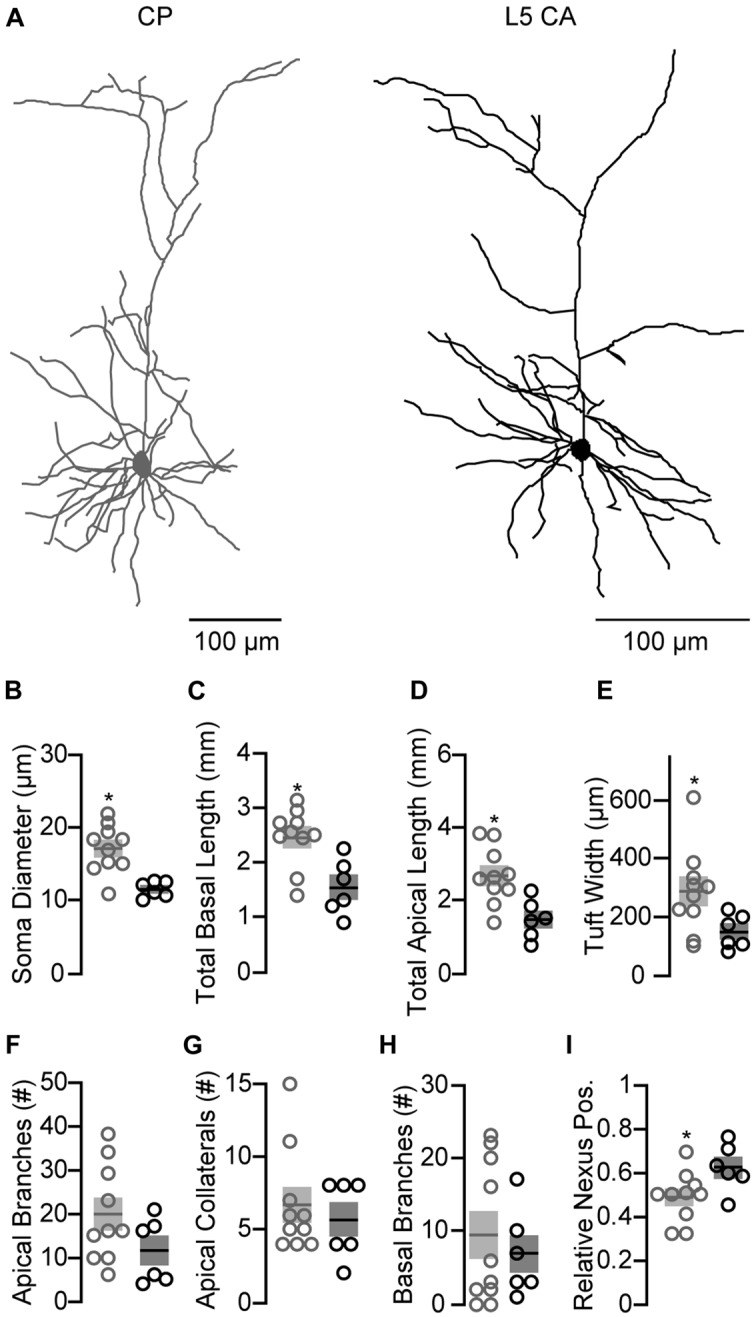
Morphological disparities between CP and CA neurons in L5 of IL. (A) Representative morphological reconstructions of CP and CA neurons in L5 of IL. (B–I) Mean (±SEM) morphological properties for the two projection classes. (∗p < 0.05, Student’s unpaired t-test).